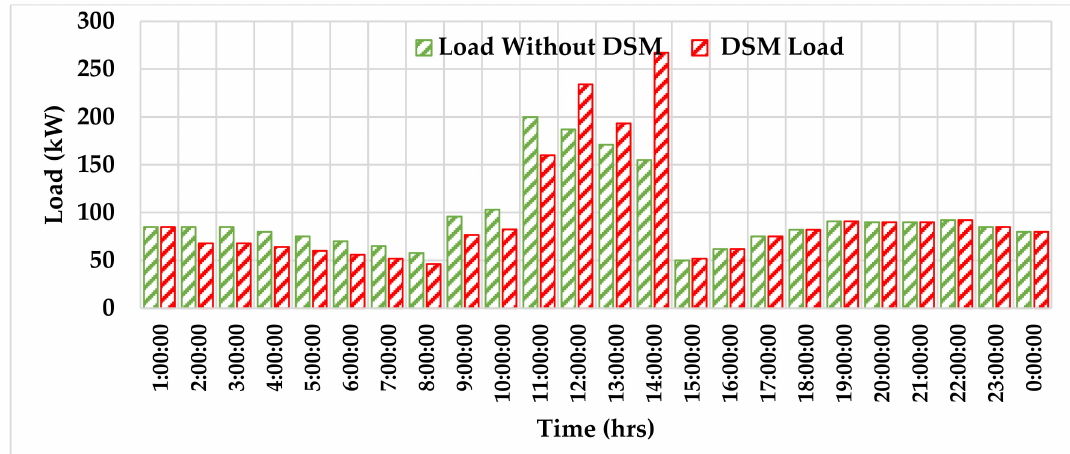
Figure 17. Daily load profile of AEO at 80%